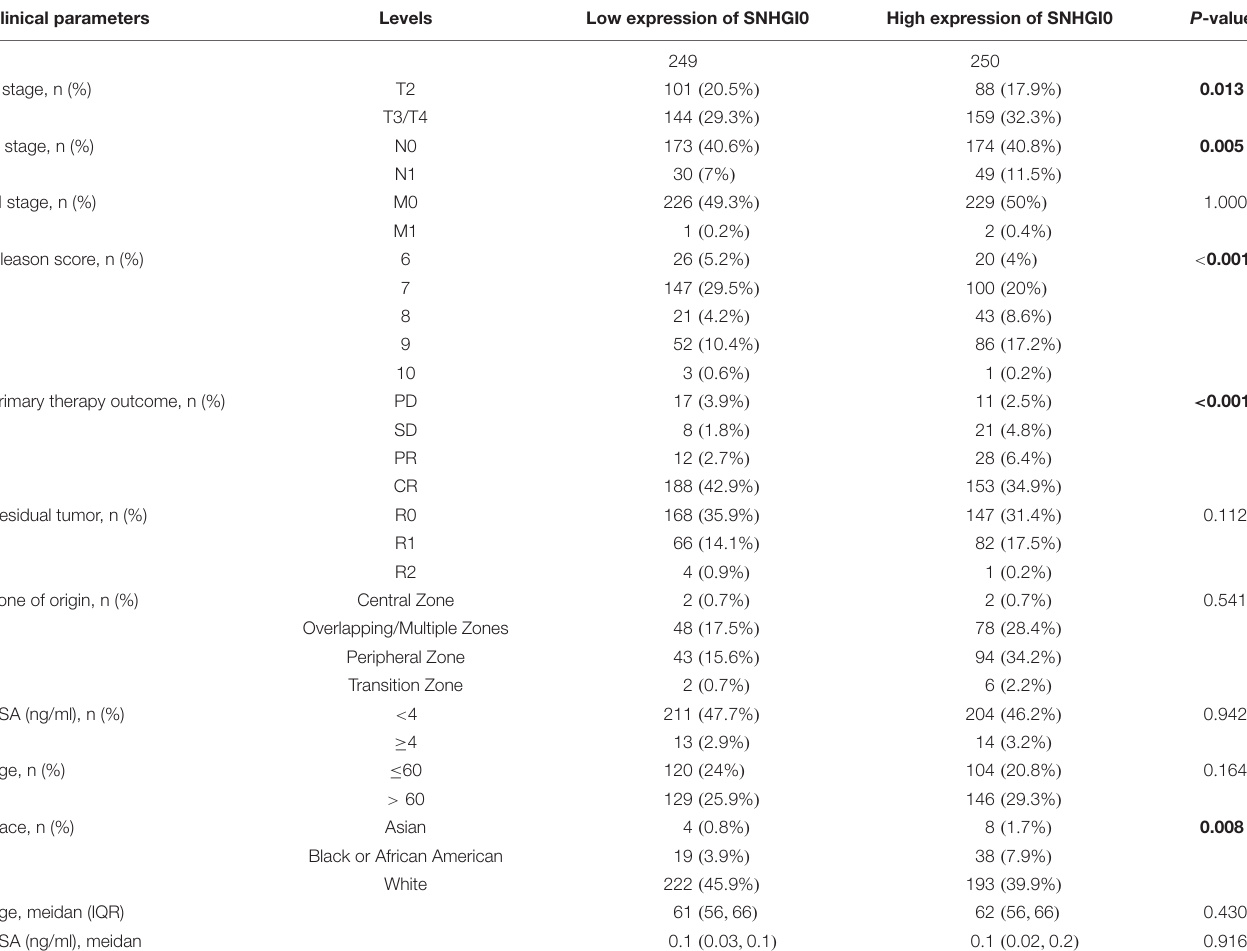
TABLE 1 | Correlation between SNHG10 expression and clinical parameters in